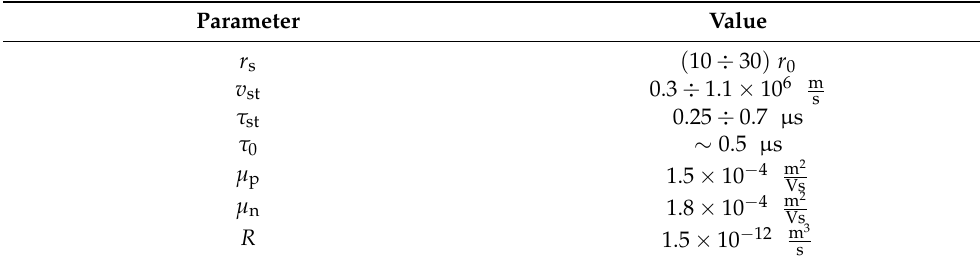
Table 2. Values of the input parameters required by Correia de Barros’